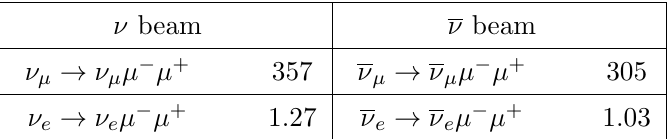
Table 3 . Number of expected events for trident processes in three years of operation of DUNE ND for each beam. We do not display the numbers for processes with one or two electrons in the (cid:12)nal state, as this will be studied in a future publication [26], however we estimated that these have a negligible e(cid:11)ect on the SMEFT (cid:12)ts. The (cid:28) trident events have vanishing